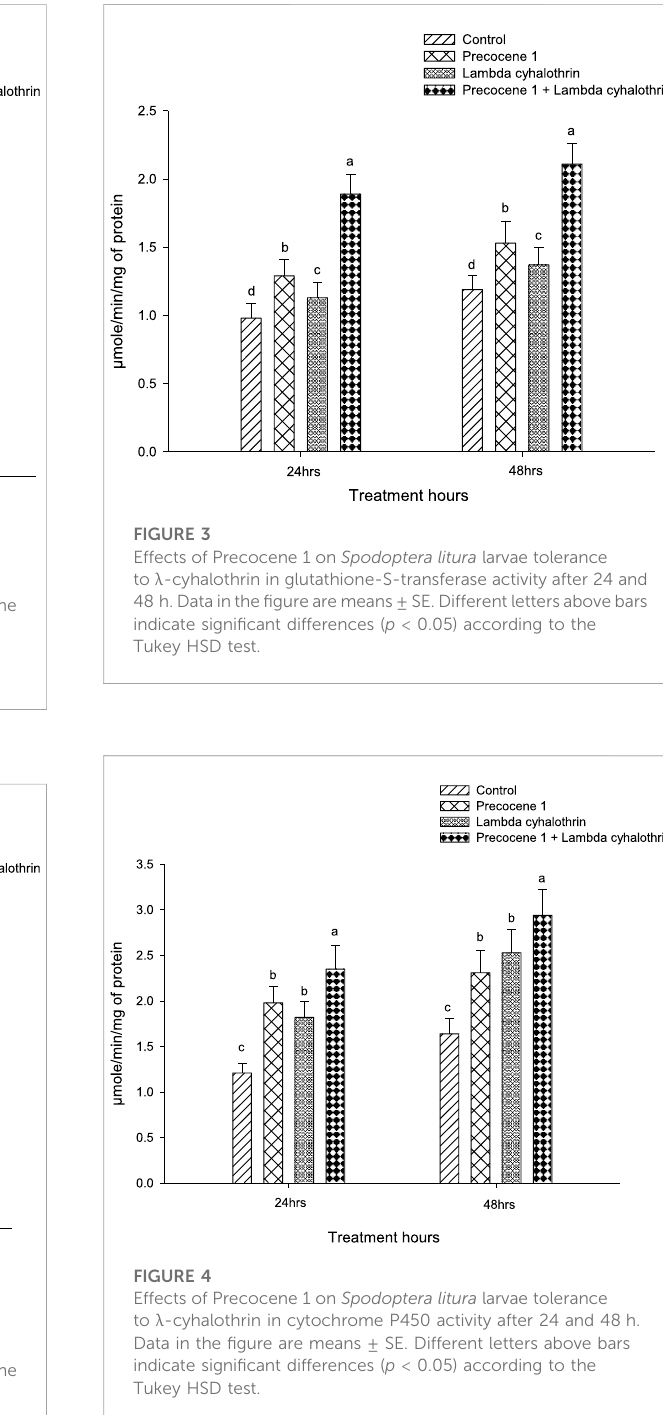
exposure, while a similar rate of enzyme activity was seen in S. litura larva at 48 h of exposure (Figure 3). The cytochrome P450 enzyme activity of S. litura in the control, Precocene 1, λ -cyhalothrin, and the synergistic effect of